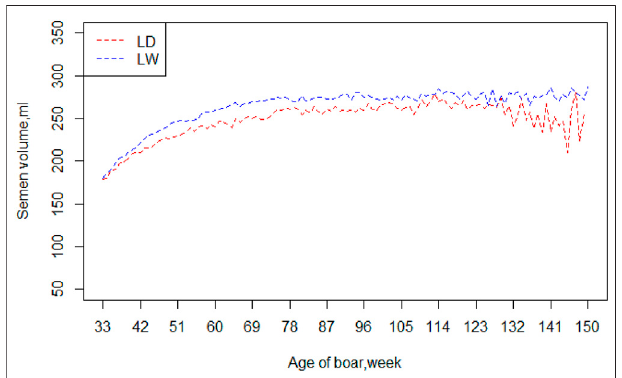
FIGURE1| Meanofsemenvolumebyageofboarsintwobreeds.Note: LD = Landrace, LW = Large White.